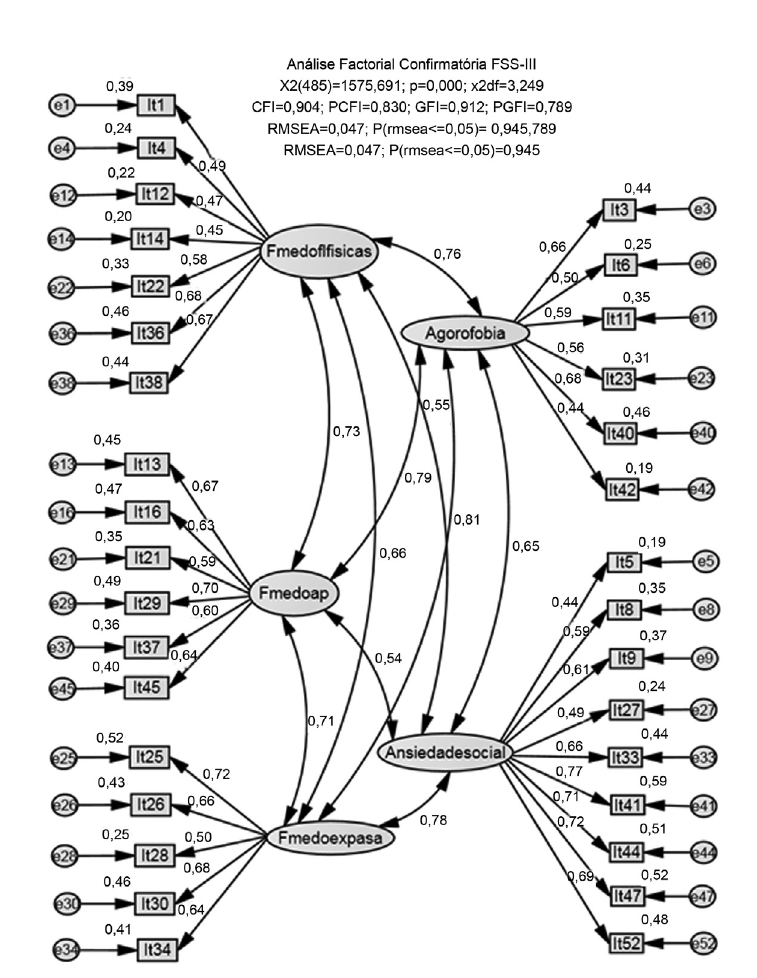
Figura 1. Modelo